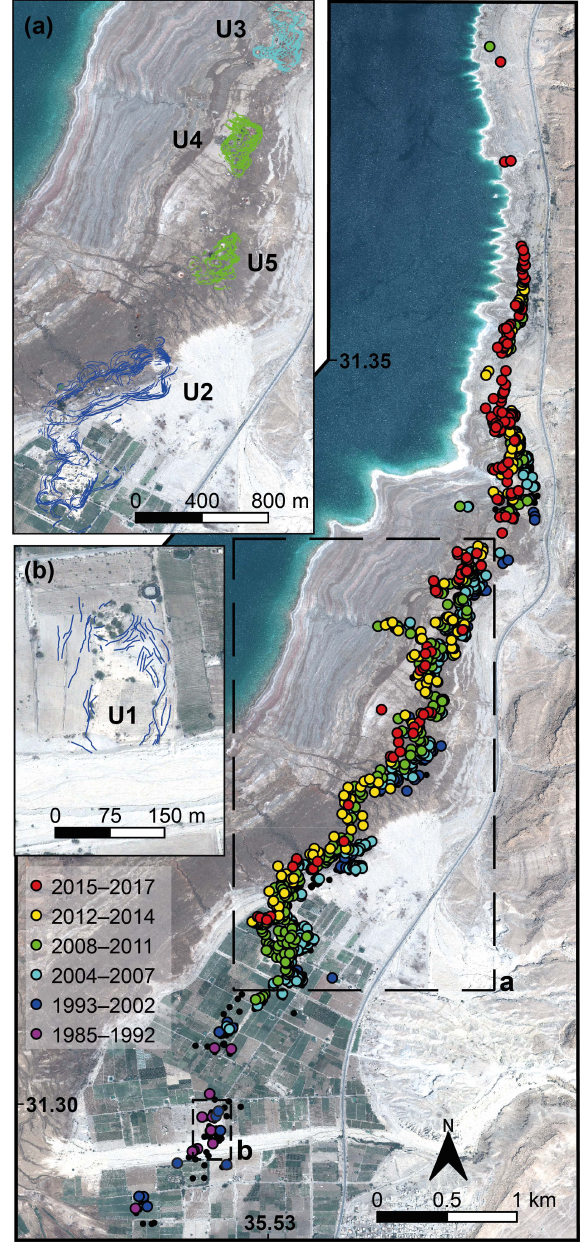
Figure 4. Sinkholes mapped from satellite and aerial imagery, colour-coded by year of first sighting in time intervals as labelled. Base image is Pleiades 2017. Smaller black dots are sinkholes mapped prior to 2009 by other sources but not visible in our im- agery. Insets (a) and (b) show the larger-scale depressions, as de- noted by mapped ground cracks and fractures. For clarity, all frac- tures for each depression are colour-coded by year of first sighting of any fractures related to that depression. In detail, the fracture for- mation ages in each large-scale depression span a greater range than shown here (see Figs. 6 and